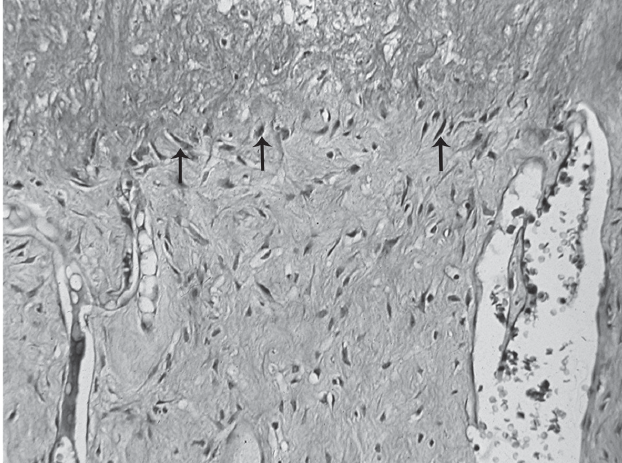
Fig. 2 - (Group III; 7th day) - Elongated cells organized in layer (arrows) in the area immediately bellow the coagulation necrotic zone. Large number of blood vessels in the subjacent pulp tissue. Hematoxylin-eosin, original magnification 125X.